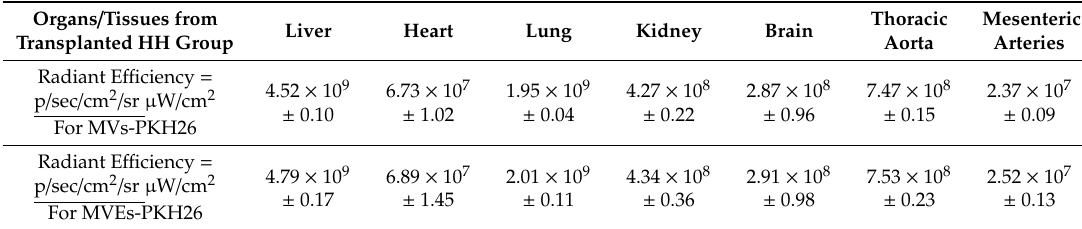
Table 1. Quantification of radiant e ffi ciency for PKH26 (Ex = 535 nm; Em = 580 nm) in liver, lung, kidney, brain, heart, thoracic aorta, and mesenteric resistance arteries by the measurement of fluorescence signals originating from MVs and MVEs labelled with PKH26 and transplanted to the HH group (transplanted HH group) under an IVIS imaging system.